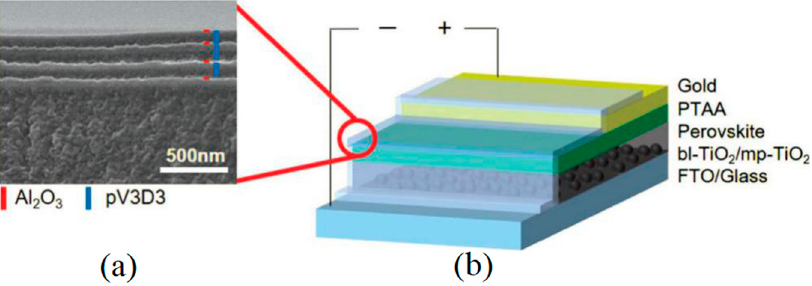
Figure 10. ( a ) The cross-sectional SEM image of the TFE, and ( b ) Schematic illustration of the en- capsulated PSC. Copyright Reproduced with permission from Ref.